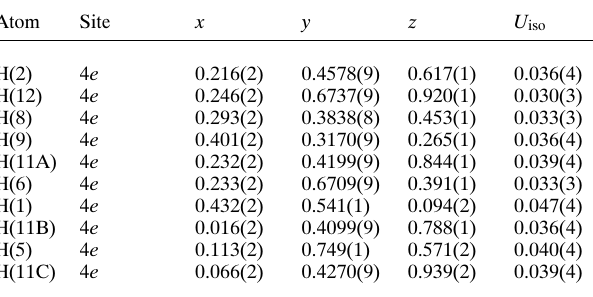
Table 2. Atomic coordinates and displacement parameters (in Å 2 )